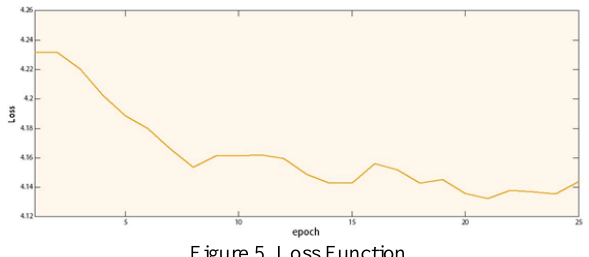
Figure 5. Loss Function